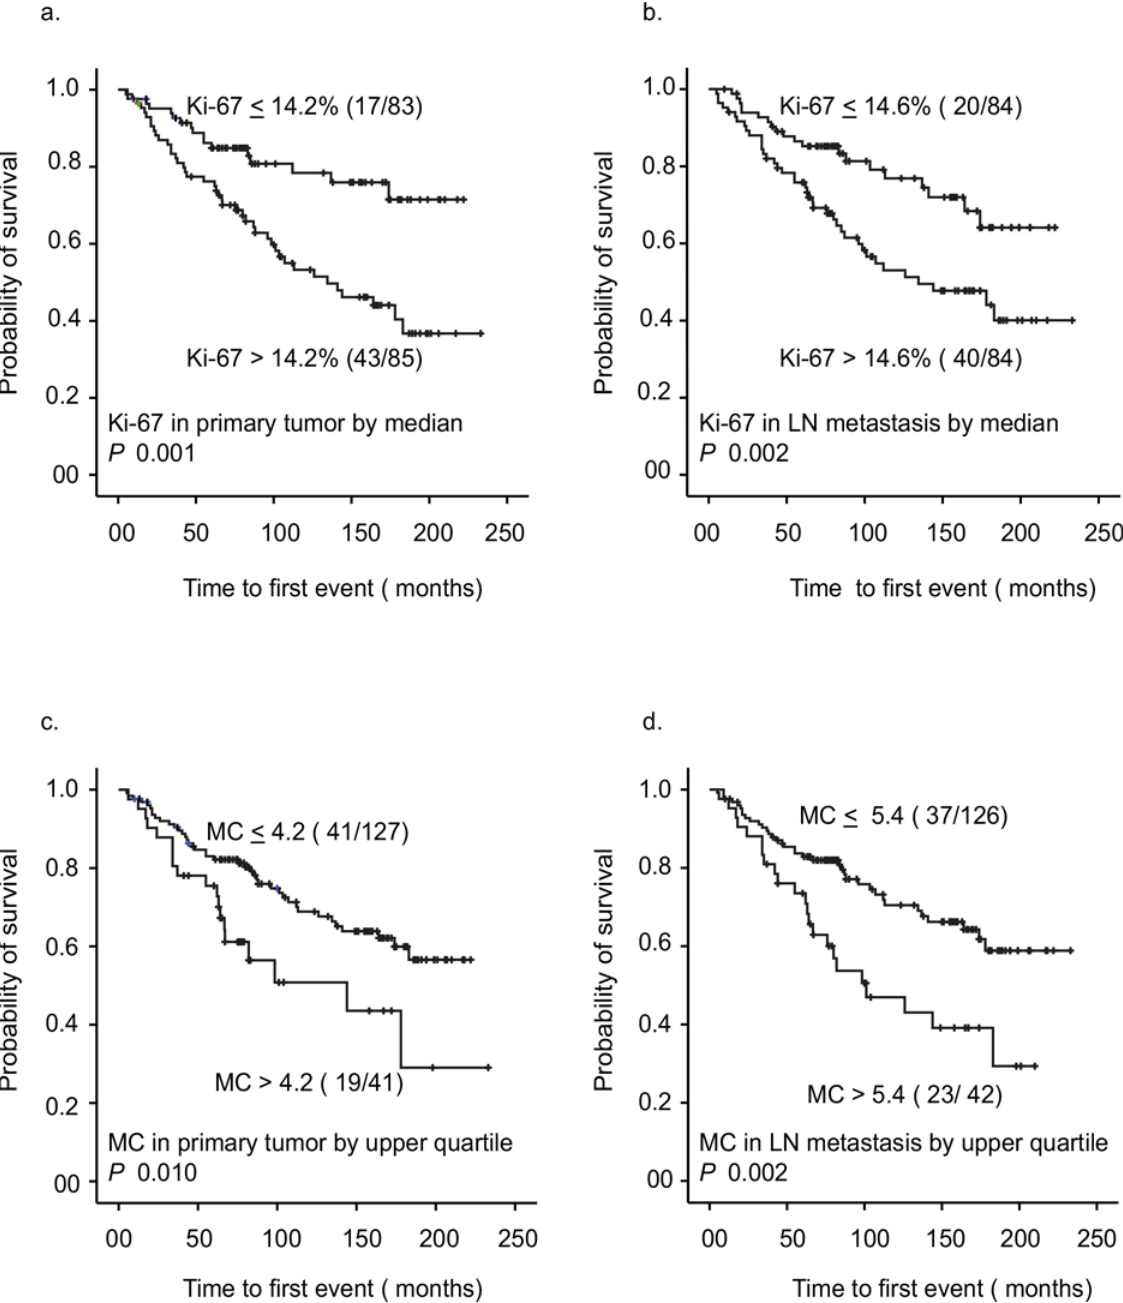
Fig 2. Survival analysis for Ki-67 and mitotic count in primary tumors and LN metastases. Survival curves (Kaplan-Meier method) are shown for Ki-67 in PT and LN metastasis (a. and b.), and MC for PT and LN metastasis (c. and d.). Number of events / number of cases are given in